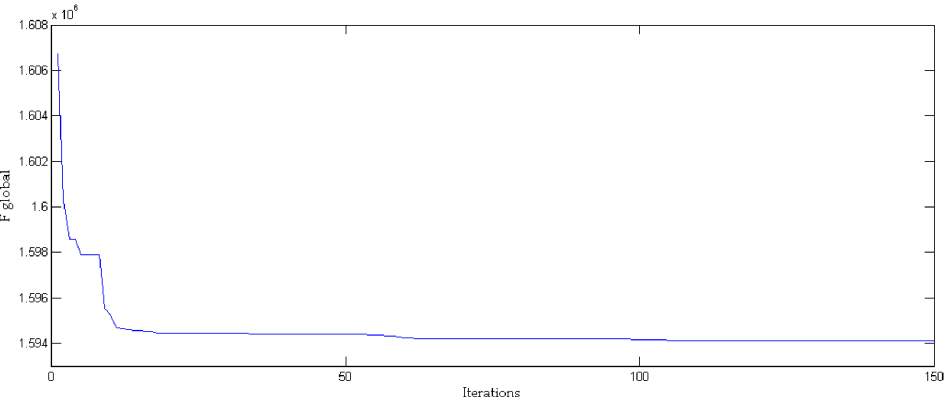
Figure 10. Optimizing curve of life cycle cost (LCC).